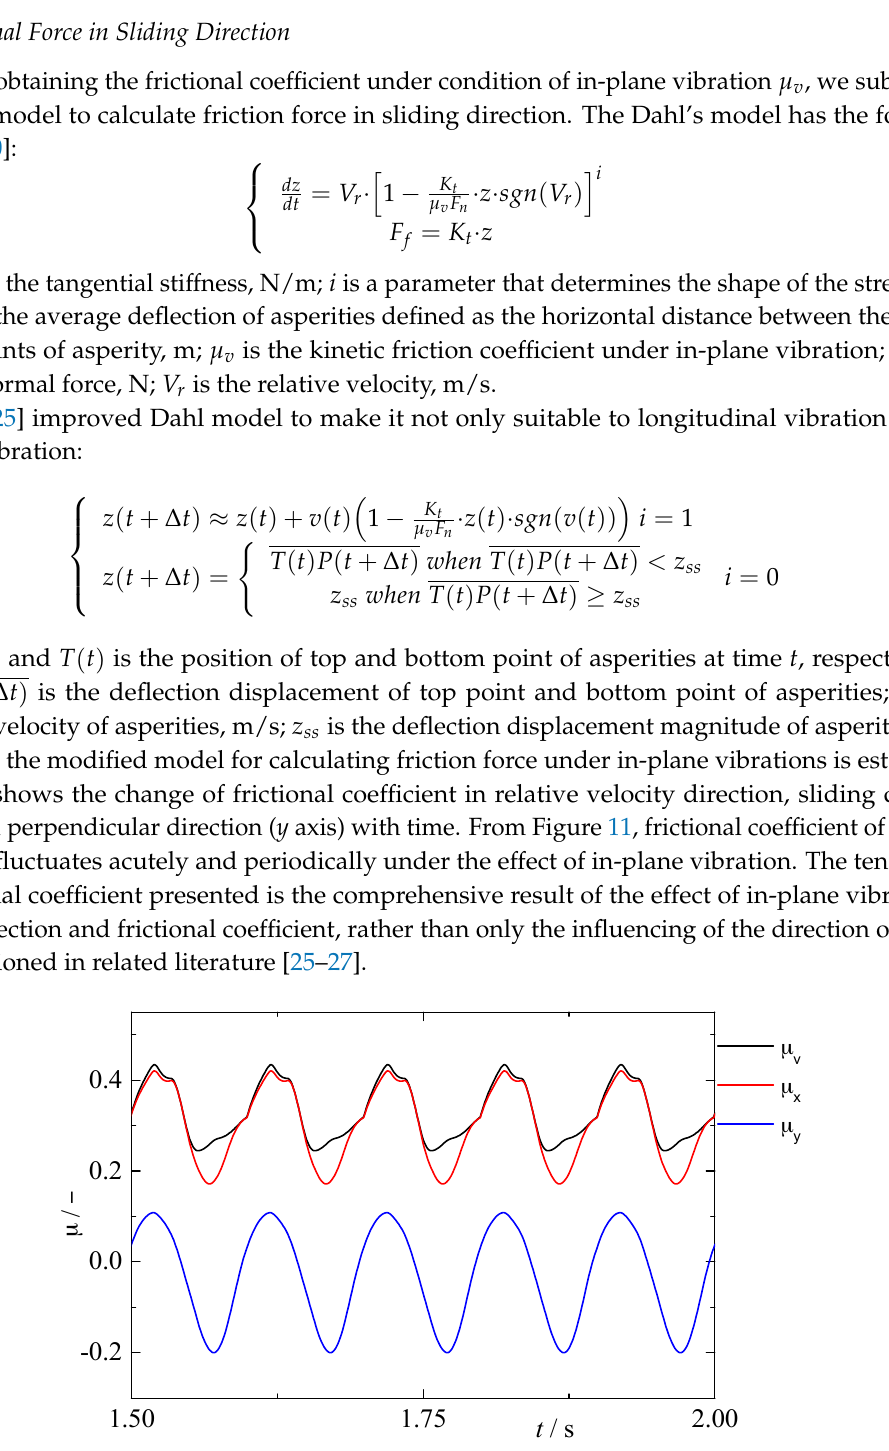
(cid:3095) , (cid:2030) = 0 , (cid:2018) = 2 , , ϕ = 0, κ = 2, 6 (cid:2874)